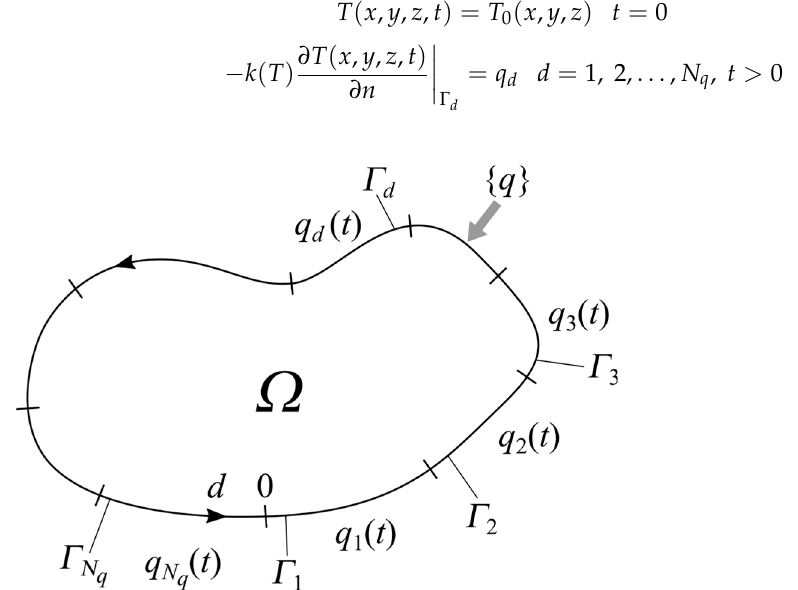
Figure 1. A direct problem with thermal boundary conditions.